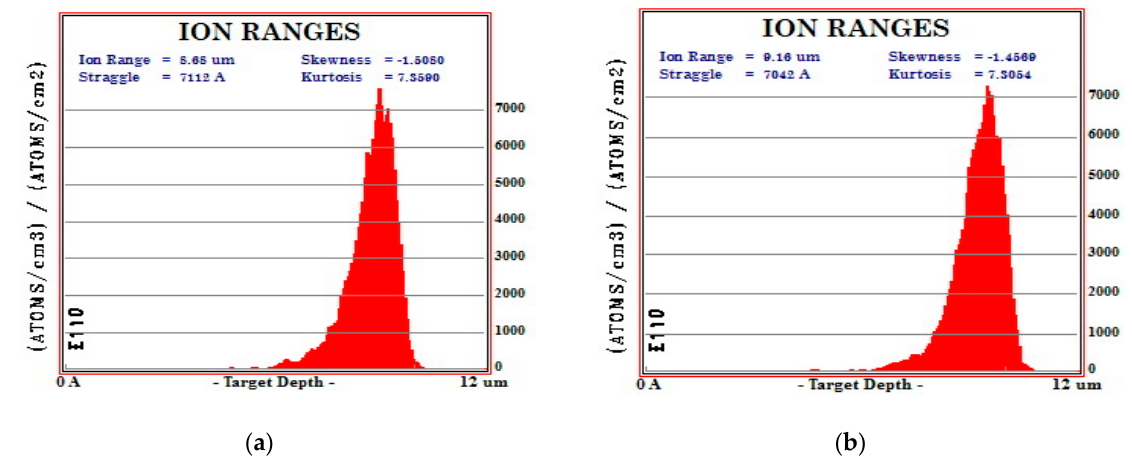
Figure 2. Ion ranges for the volatile FPs: ( a ) Iodine (I) with recoil energy 90 MeV; and ( b ) Cesium (Cs) with recoil energy 95 MeV, in E110 alloy.